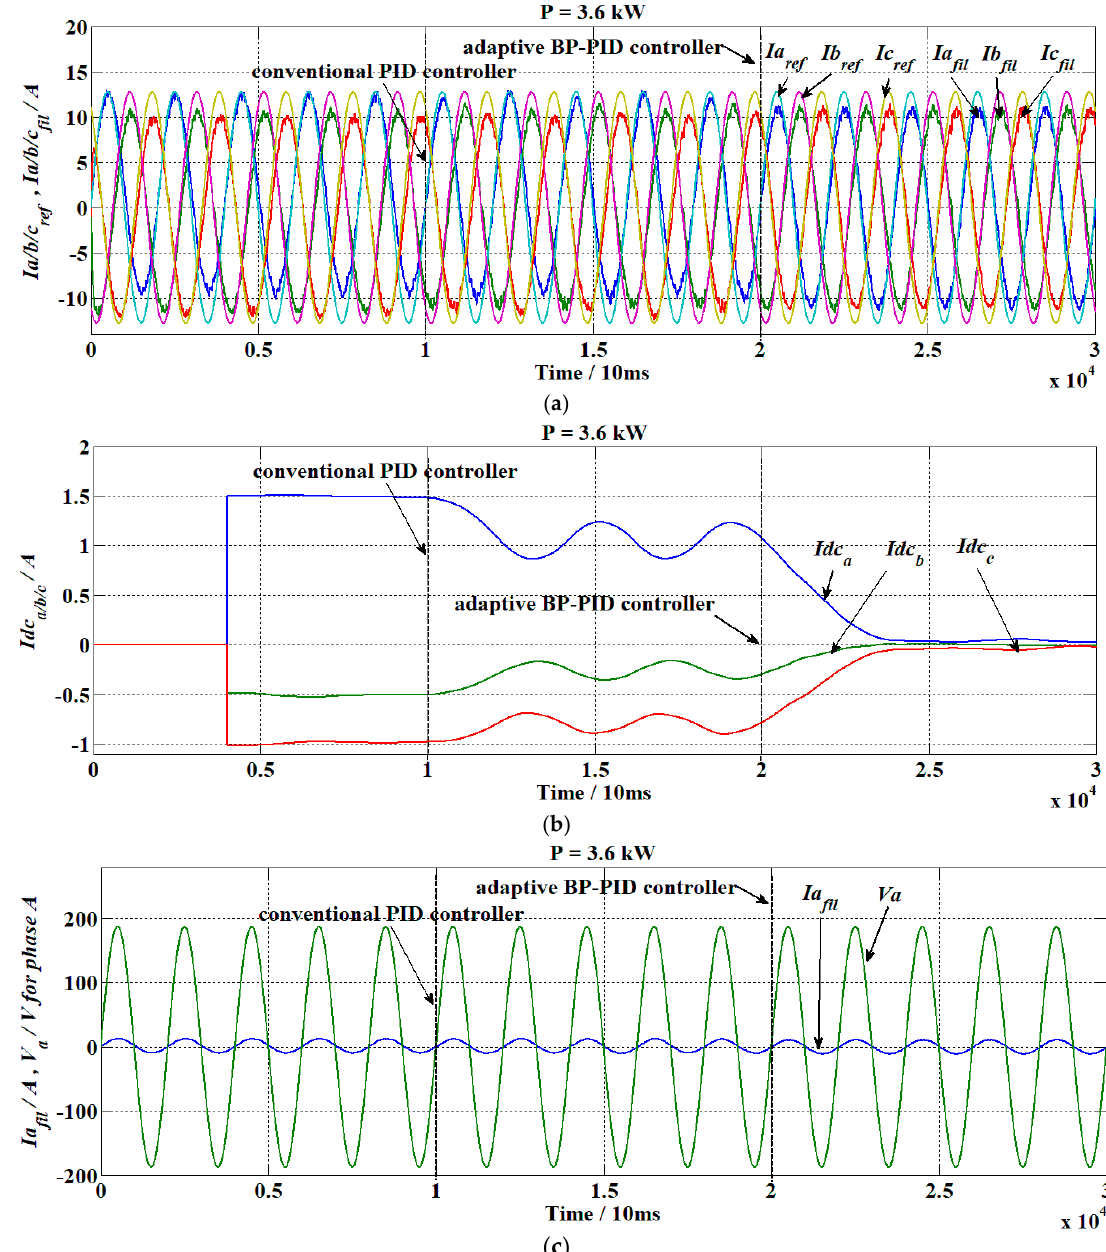
Figure 7. Waveforms of dc component, grid voltage and current using PID controller and adaptive BP-PID controller for dc-component suppression in three-phase system with ( P = 3.6 kW, Q = 0), respectively. ( a ) reference and feedback currents. ( b ) dc component of three-phase currents. ( c ) current and voltage output of phase-A.